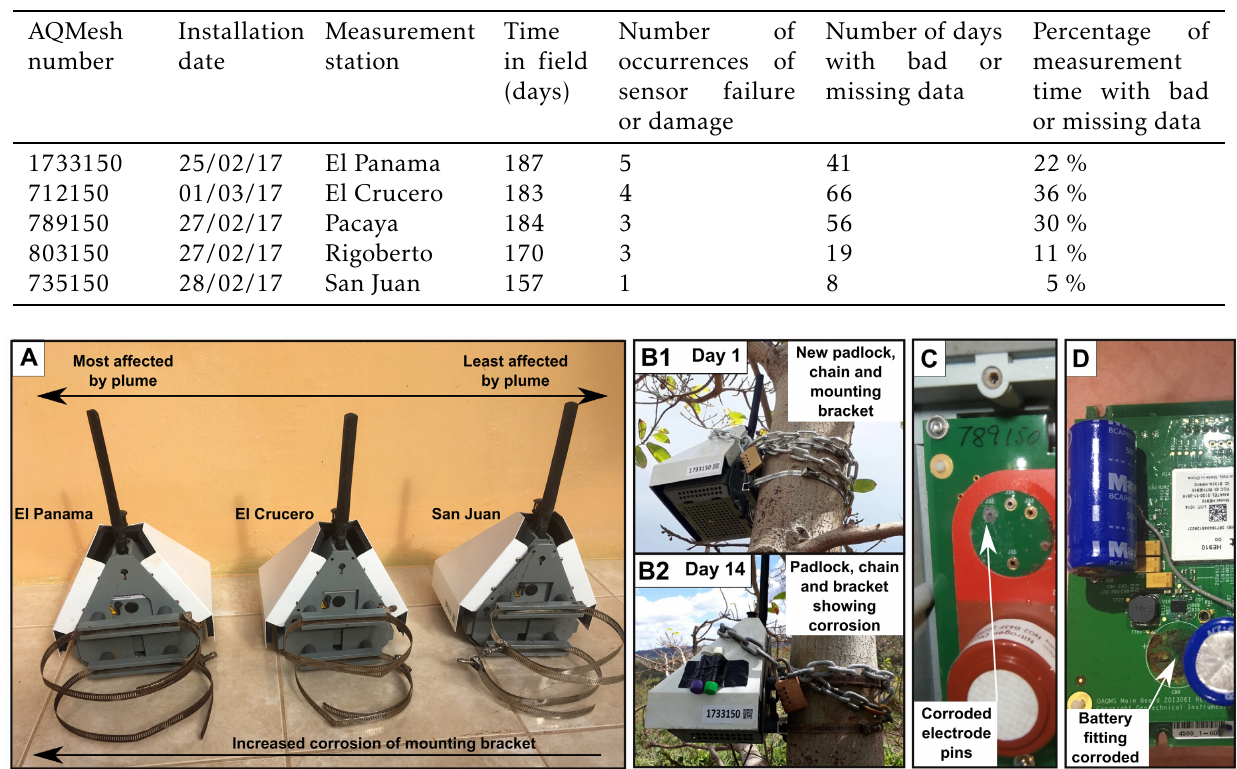
Figure 3: Issues with AQMesh pod corrosion and maintenance. [A] corrosion of metal installation mounting bracket is more advanced in measurement stations more frequently impacted by the volcanic plume; [B] cor- rosion as a result of the volcanic plume is fast-acting. AQMesh pod 1733150 installed at El Panama with new metal fittings, padlock, and chain [B1] shows obvious signs of corrosion after 14 days [B2]; [C] mounting board for the electrochemical sensors with signs of corrosion on the electrode pins for one of the sensors; [D] an AQMesh internal computer board which controls the sensors showing signs of corrosion with one of the board battery units